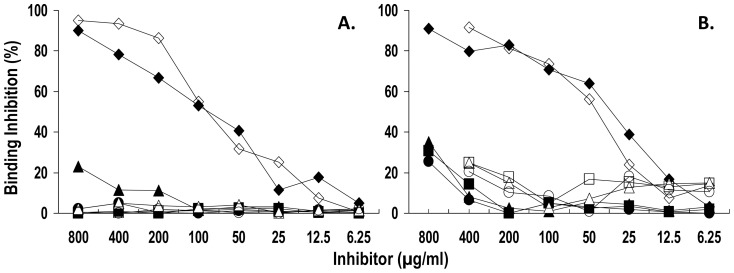
Specific peptide inhibition of phage particle binding to anti-Ap1-17 IgG demonstrates that phage insert sequences recognize the antigen-combining sites of anti-Ap1-17 IgG.Microtiter plates were coated with affinity-purified anti-Ap1-17 IgG from pt4 (A.) or pt14 (B.). After the blocking of free protein-binding sites with PBS-BSA, wells were incubated for 2 h with 50 µl PBS containing serial dilutions of either free (closed symbols) or KLH-conjugated (open symbols) Ap1-17 (rhombus), Ap17-30 (triangle), CBp1-13 (circle) or Qp-1a (square). Then, without removing the inhibitor, 50 µl/well of an appropriate dilution of phage supernatant pc4.33 (A.) and pc14.49 (B.) was added and incubation prolonged for 2 h. Bound phage particles were detected by sequential addition of HRP-anti-M13 mAb and o-phenylenediamine solution. Results are expressed as percentage of binding inhibition. Each data point is the mean of duplicate wells. The data are representative of two experiments. The maximum amount of inhibitor (800 µg) corresponds to 382 nmol Ap1-17, 558 nmol Ap17-30, 486 nmol CBp1-13 and 574 nmol Qp-1a.